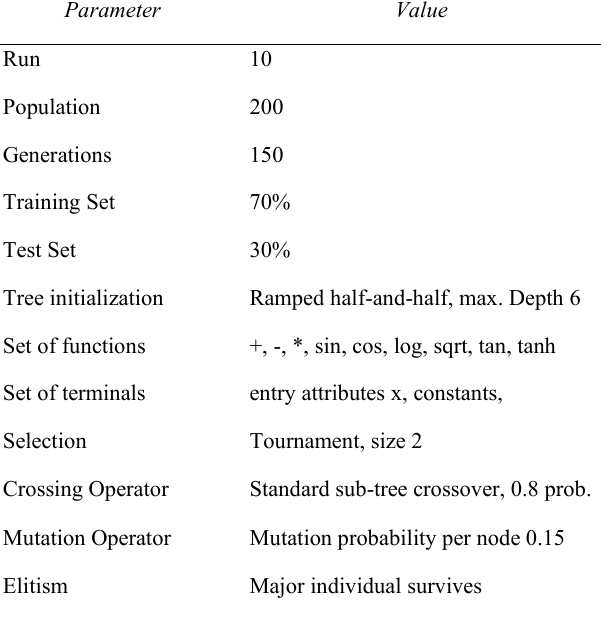
Figure 3. Transformation of tree to binary output